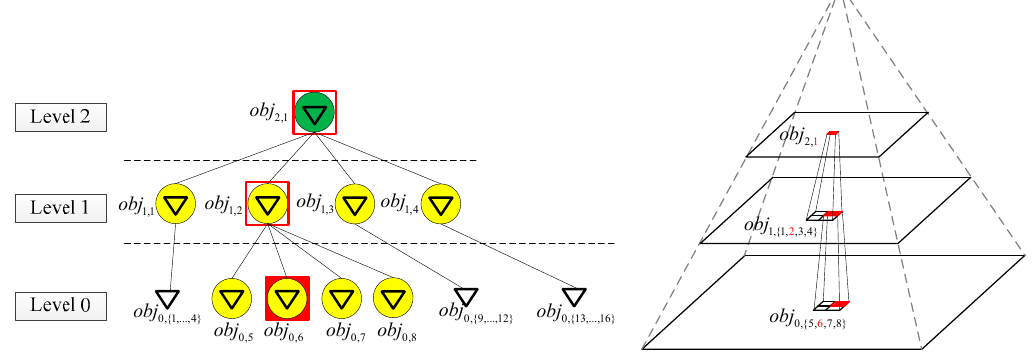
Figure 10. The image pyramid search technique.